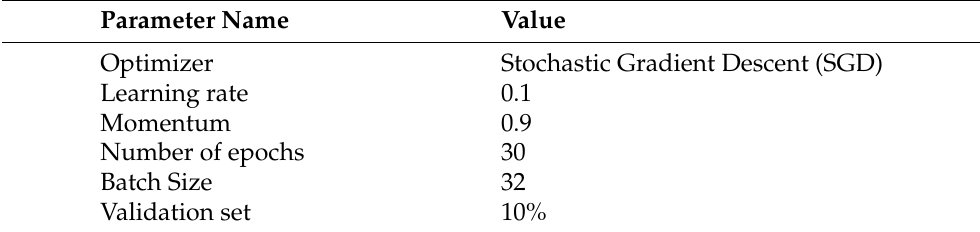
Table 1. Parameters used in the